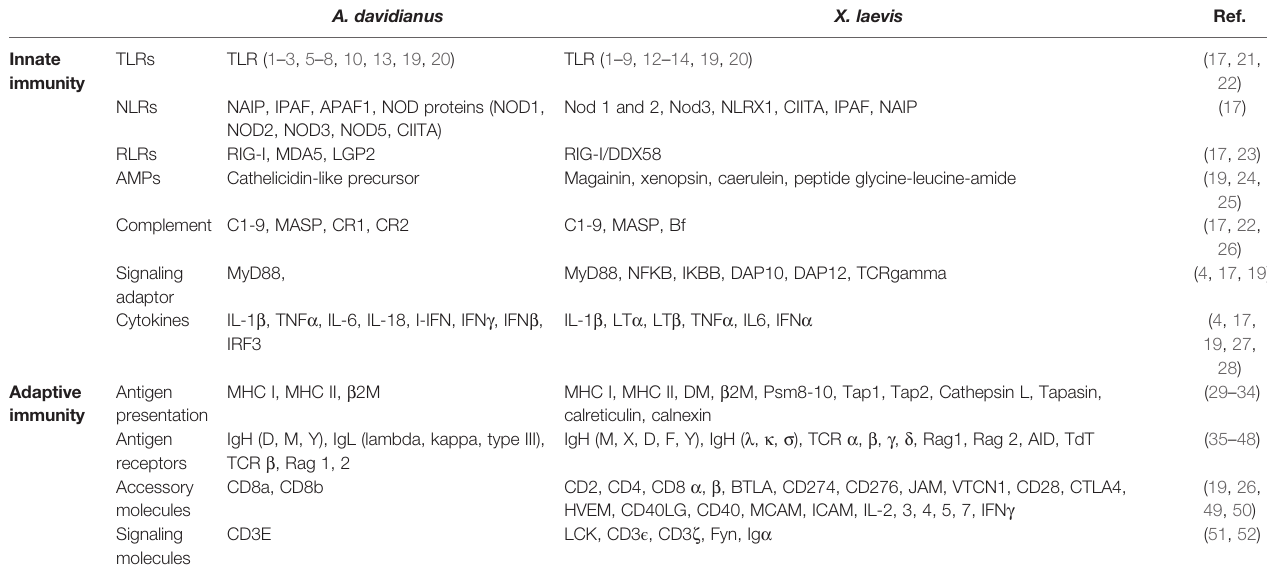
TABLE 1 | Identi fi ed immune genes of A. davidianus and X.